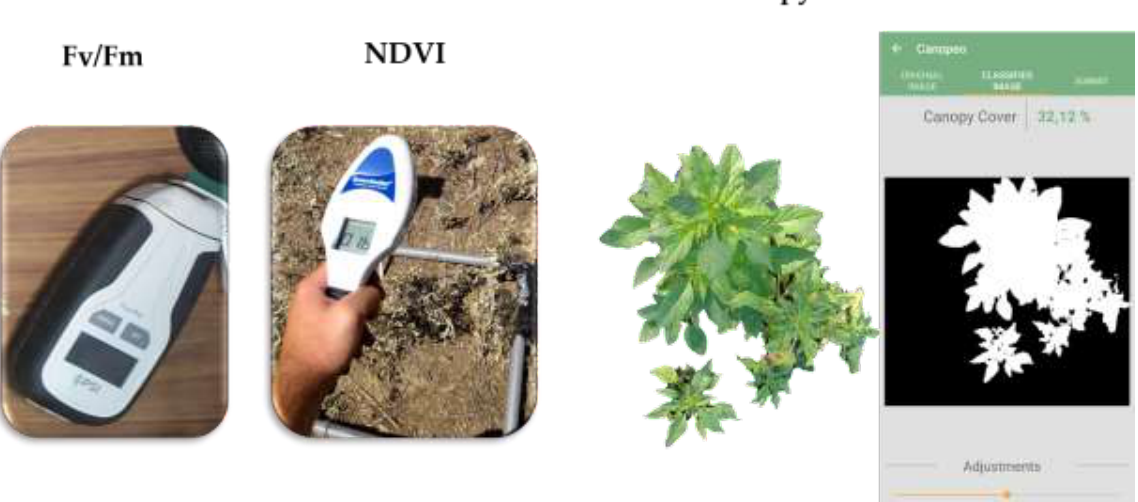
Figure 1. Use of handheld instruments and smart applications to measure Fv/Fm, NDVI and canopy cover